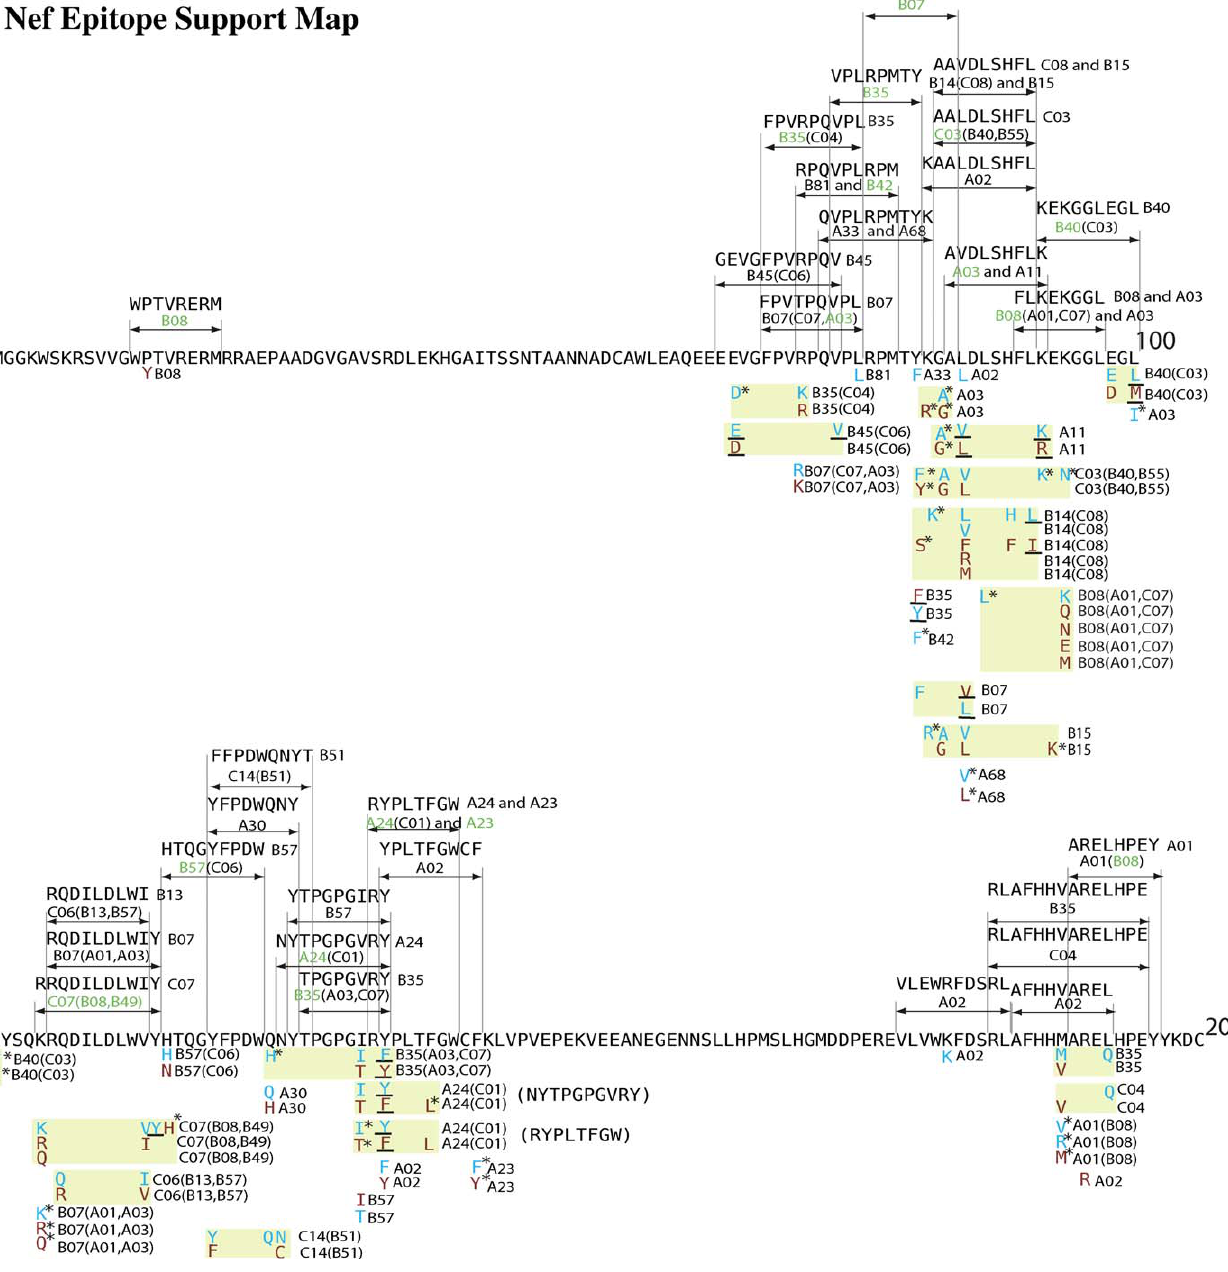
Figure 3. Epitope Support Map: HLA-Associated Polymorphisms Mapping within or Directly Proximal to Published HLA-Restricted CTL Epitopes in Nef HLA-associated polymorphisms occurring within or directly proximal ( 6 3 aa) to published HLA-restricted CTL epitopes in Nef are shown. Polymorphisms associated with the same HLA allele(s) occurring within, or directly proximal to ( 6 3 aa) published HLA-restricted epitope boundaries are boxed together in yellow. The published epitope sequence (and associated HLA) is indicated above the epitope boundary arrow. If associations within the same epitope boundaries are ascribed to several linked HLA alleles, the HLA that is known to present the epitope is indicated next to it. Red ( ‘‘ escape ’’ ) amino acids indicate positive correlations (amino acids that are enriched in the presence of a specific HLA allele). Thus, ‘‘ escape ’’ (red) amino acids presumably reflect the escape variant specific for that HLA allele. Blue ( ‘‘ reversion ’’ ) amino acids indicate negative correlations, where the presence of a specific HLA allele is associated with the absence of a particular amino acid at a specific position—or, likewise, where the absence of the specific HLA allele is associated with the presence of this amino acid. Thus, ‘‘ reversion ’’ (blue) amino acids presumably reflect the immunologically susceptible form specific for that HLA allele, and the amino acid to which the sequence may revert upon transmission to an individual lacking that HLA allele. Underlined associations indicate potential HLA anchor residue sites. Proximal associations (within 6 3 aa of epitope boundaries) are marked with an asterisk (*). Associations additionally supported by functional IFN- c (ELISpot) data are indicated in green